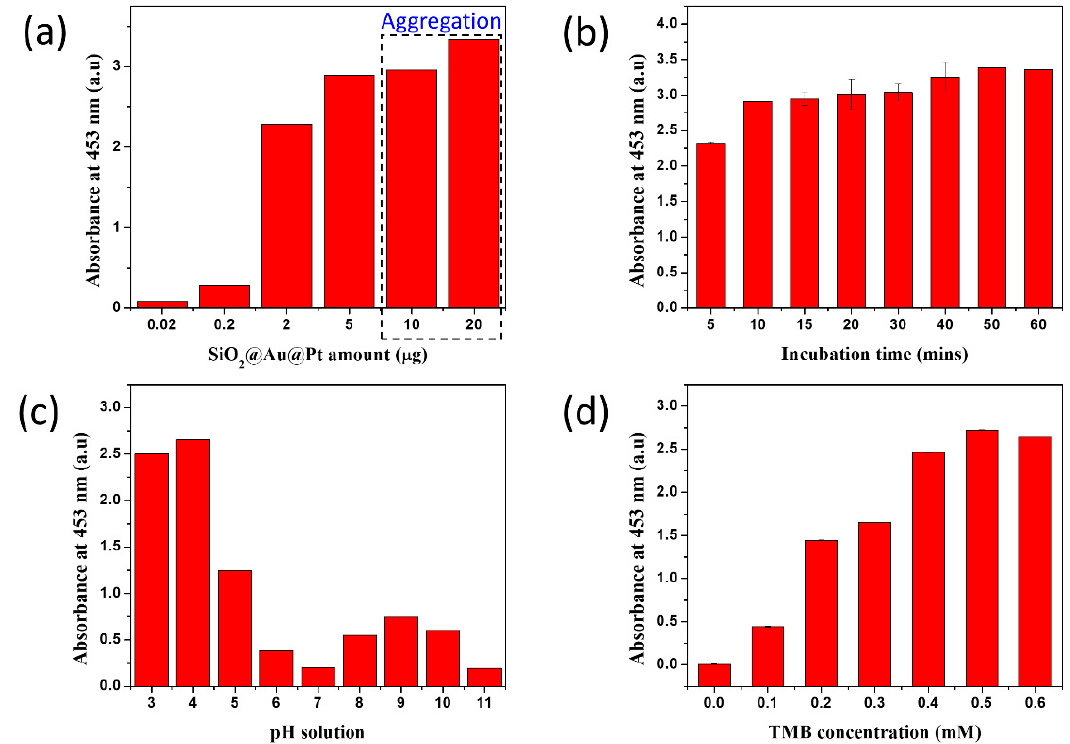
Figure 4. The effects of different conditions on the peroxidase-like catalytic activity of SiO 2 @Au@Pt NPs in a mixture of TMB and H 2 O 2 . ( a ) The amount of SiO 2 @Au@Pt, ( b ) incubation time, ( c ) pH of the solution, and ( d ) TMB concentration were varied.